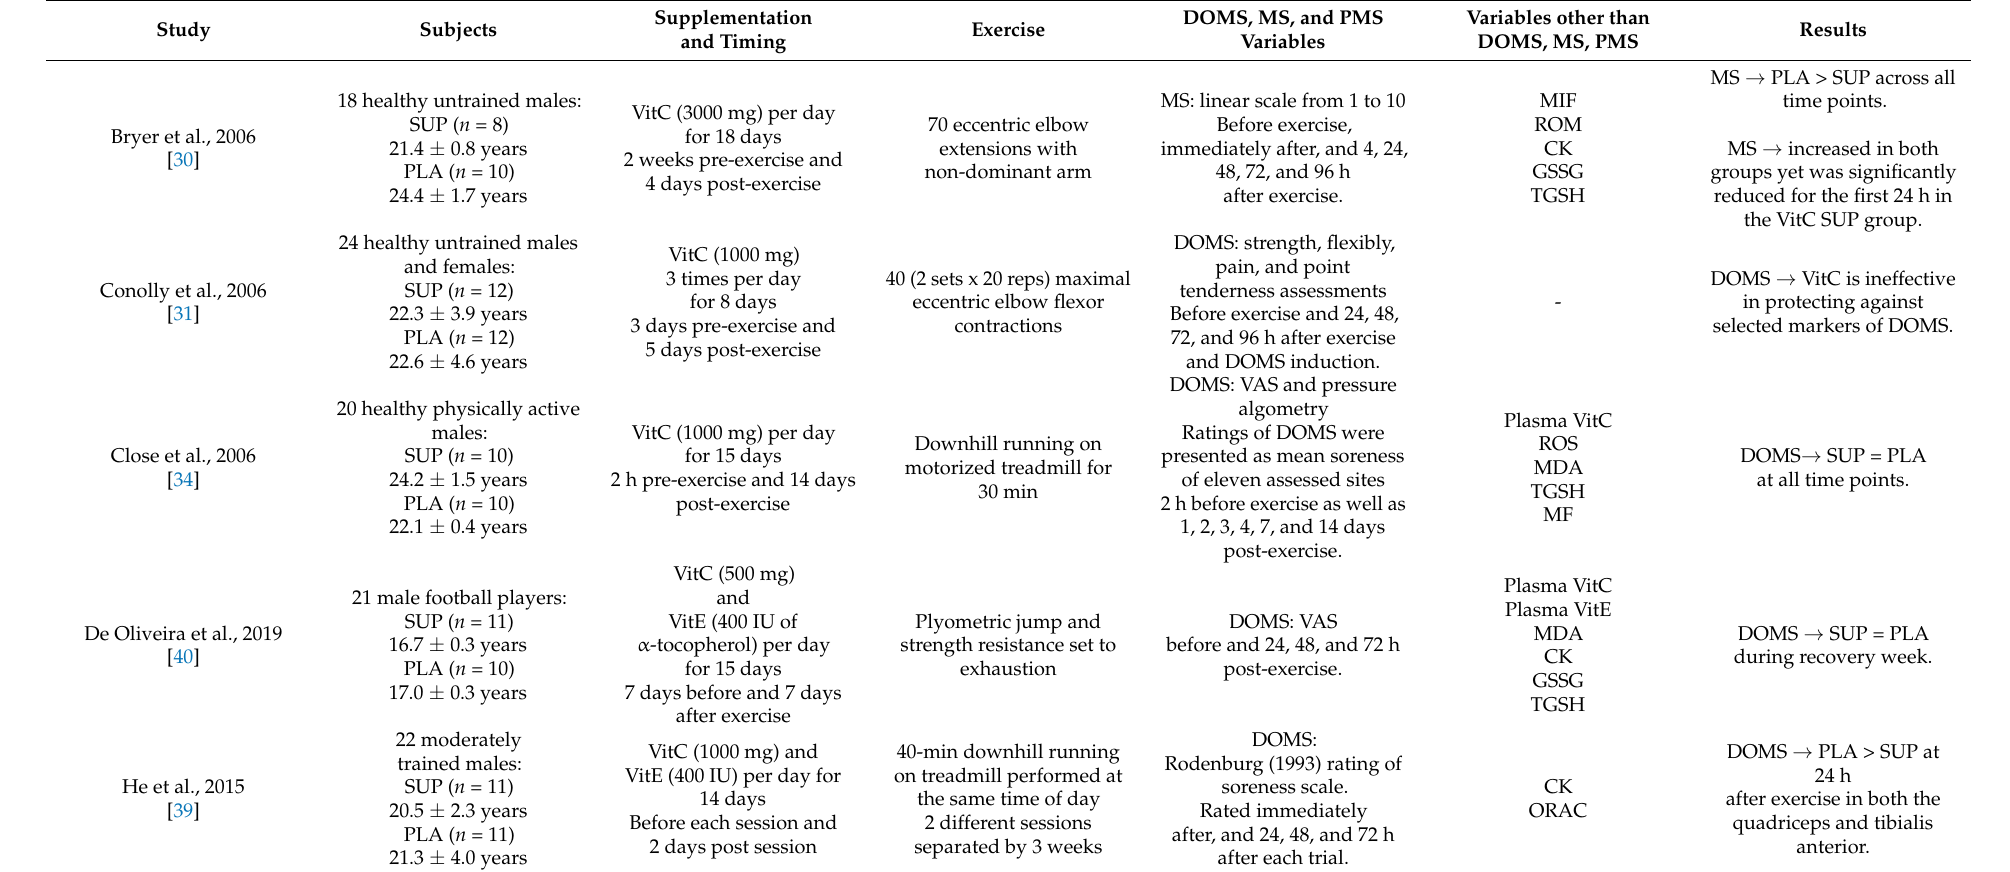
Table 2. Results and details of the reviewed